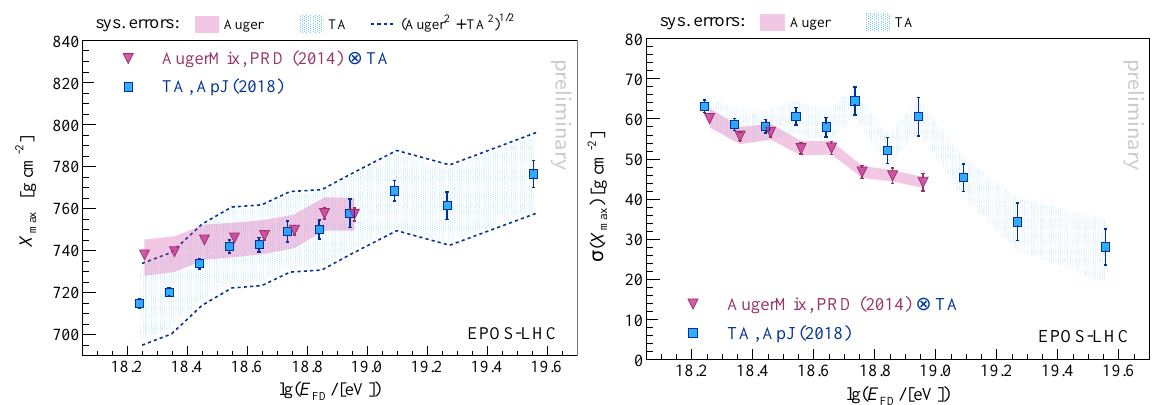
(cid:105) (left) and σ ( X Figure 8. Comparison of (cid:104) X ) (right) of AugerMix ⊗ TA for EPOS-LHC (representing the Auger data transferred max max into the TA detector) to the TA BR / LR measurements [6]. Error bars show the statistical errors, shaded areas — the systematic uncer- (cid:105) plot — systematic uncertainties of the Auger and TA X tainties of each of the experiments, dashed lines in the (cid:104) X max combined in quadrature.